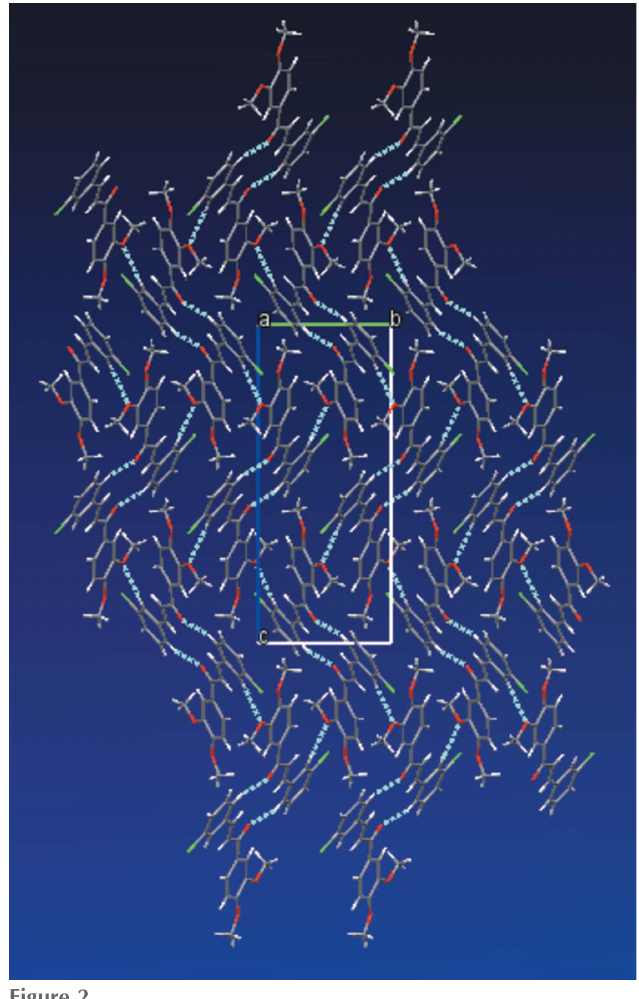
Figure 3 View of the three-dimensional Hirshfeld surface of the title compound mapped over d norm .